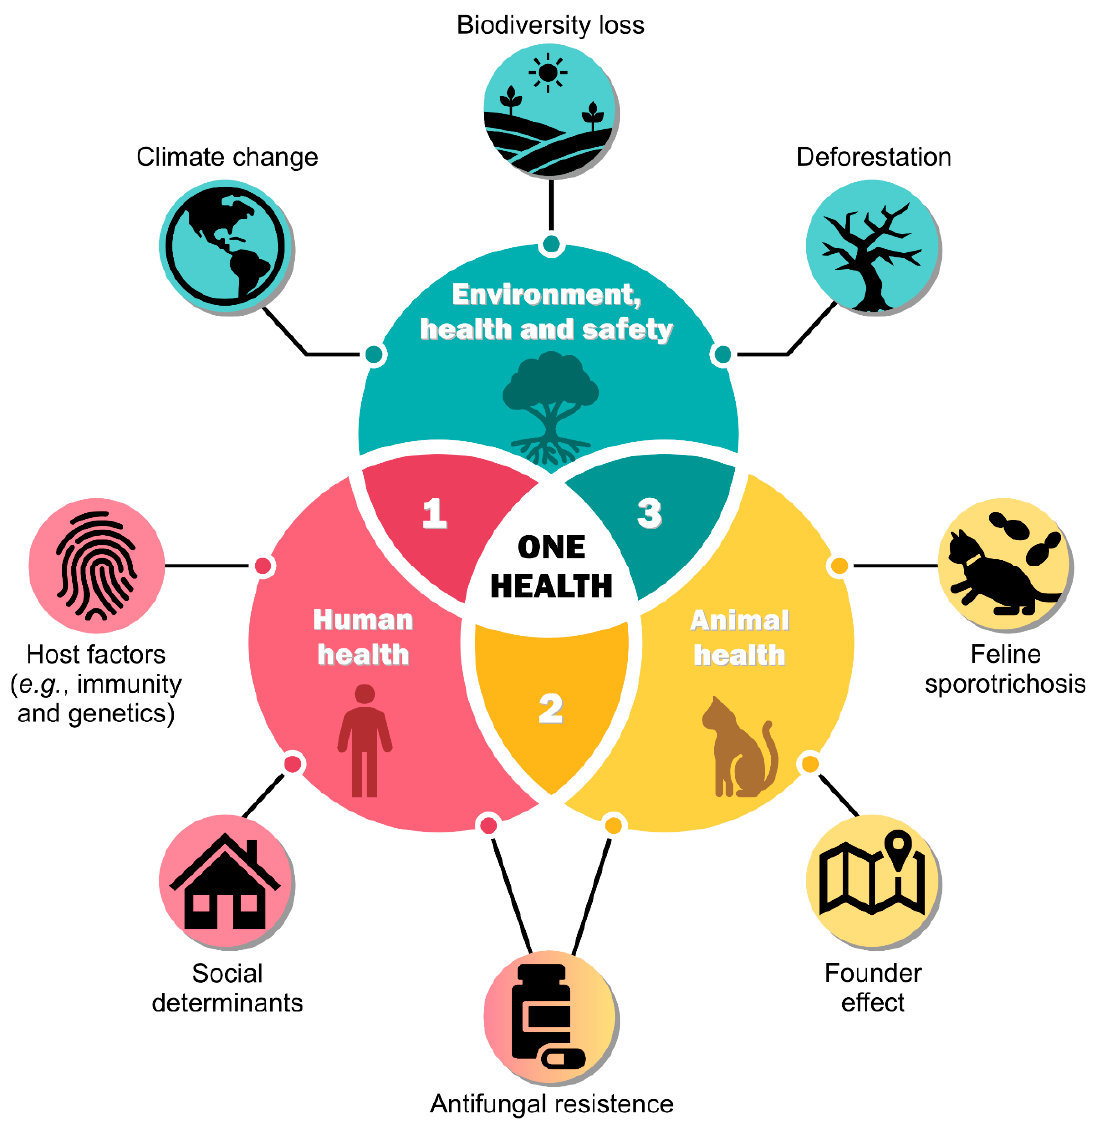
Figure 4. A one-health approach to mitigating the spread of cat-transmitted sporotrichosis considers human health (1), animal health (2), and environmental health and safety (3).